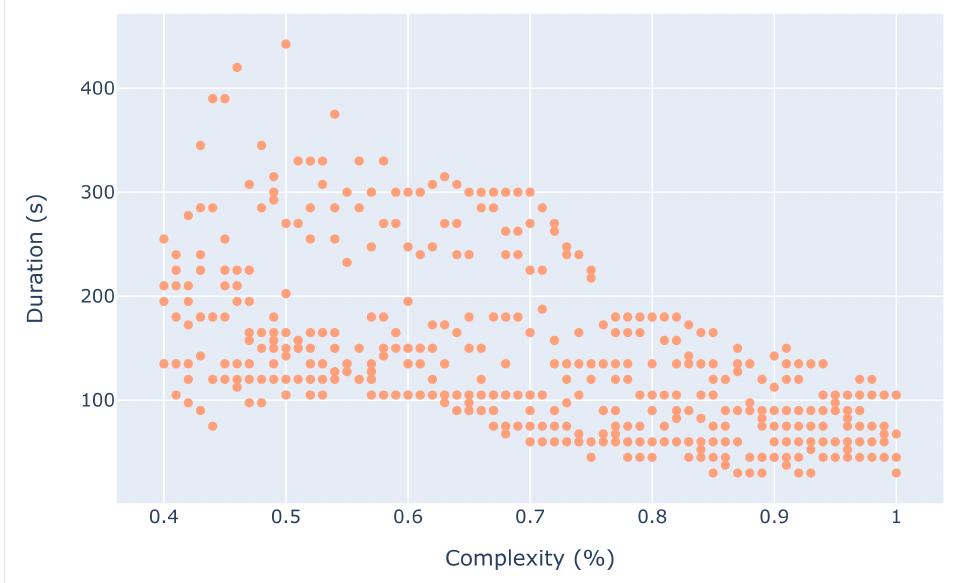
Figure 29. Duration of communities for different complexity thresholds (distance threshold < 25 NM).